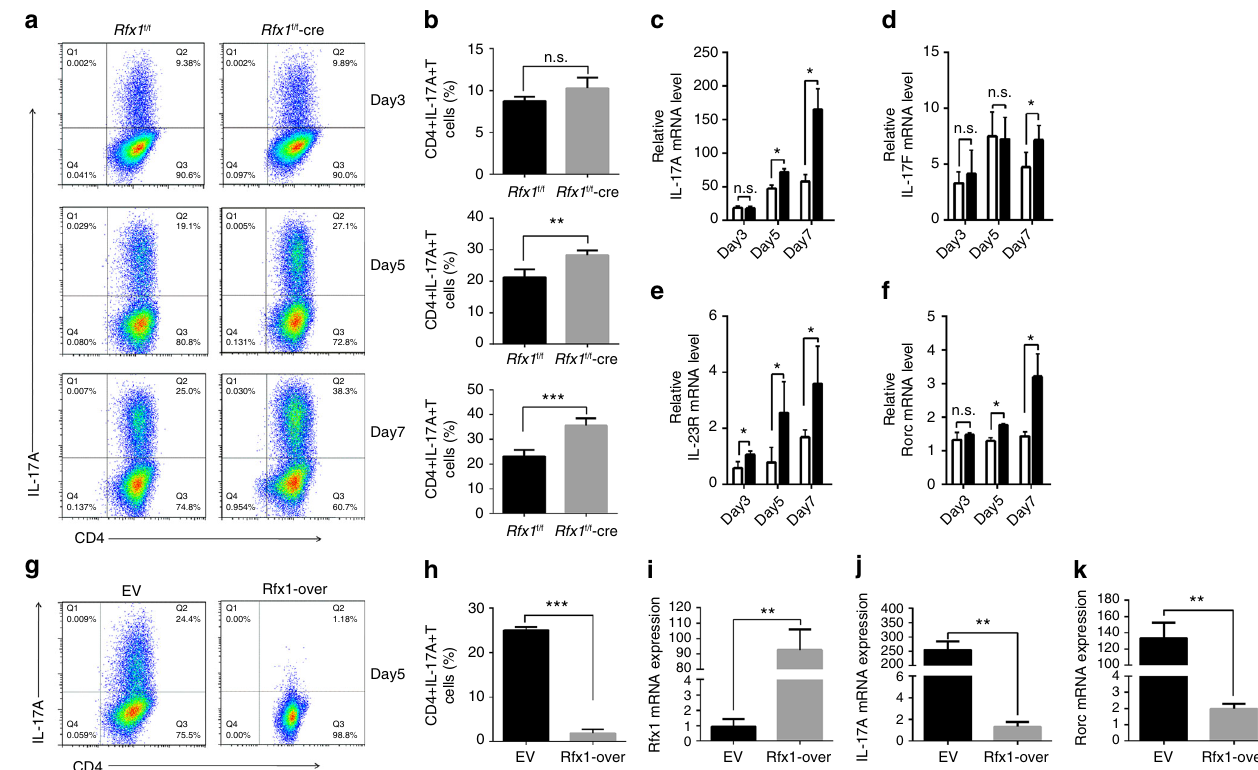
Fig. 6 RFX1 restrains Th17 cell differentiation in vitro. a Representative fl ow cytometric analysis of Th17 cells polarized from naive T cells of Rfx1 f/f and Rfx1 f/ f -cre mice on days 3, 5, and 7 in the left panel. b shows the quanti fi cation (mean ± s.d.; n = 4 mice per group). c – f mRNA expression levels of Th17-related genes, including IL-17A ( c ), IL-17F ( d ), IL-23R ( e ), and Rorc ( f ) (mean ± s.d.; n = 4). g , h Flow cytometric analysis of in vitro-induced Th17 cells from naive T cells of Rfx1 f/f -cre mice transfected with mouse Rfx1 expression vector (Rfx1-over) or empty expression vector (EV) 5 days after transfection. i – k mRNA expression levels of Rfx1 ( i ), IL-17A ( j ), and Rorc ( k ) genes in Th17 cells induced in vitro. Data are representative of three independent experiments (mean ± s.d.; n = 3). * P < 0.05; ** P < 0.01; *** P < 0.001; n.s., not signi fi cant, two-tailed Student ’ s t